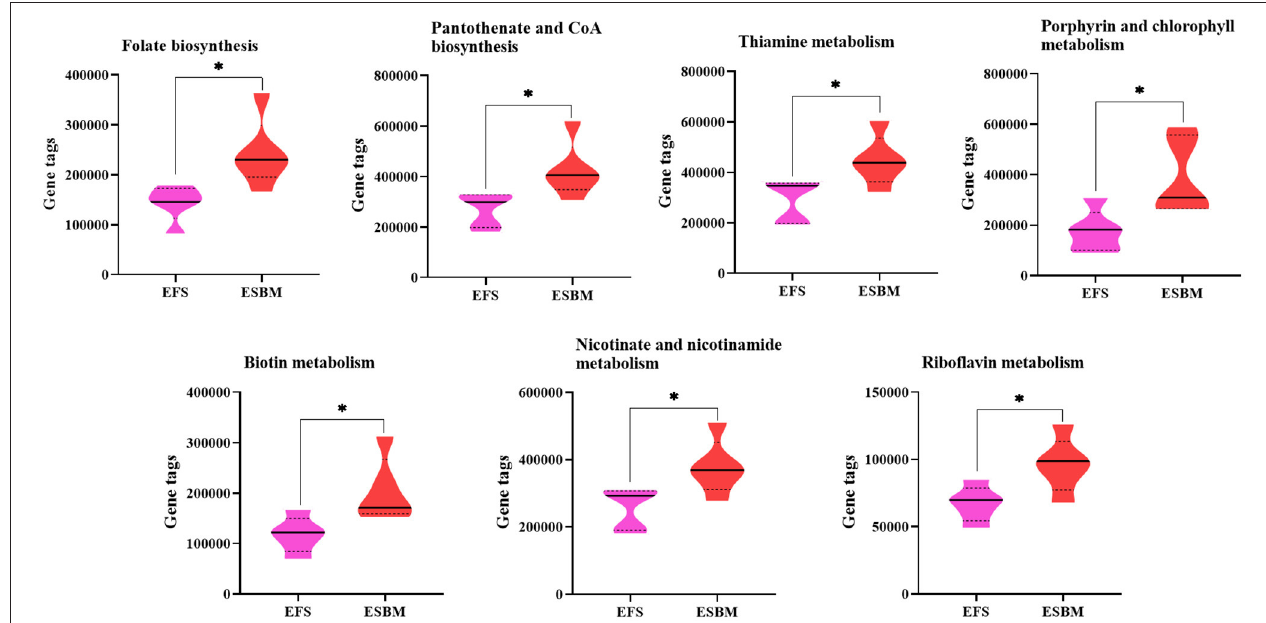
FIGURE 5 | Prediction on vitamins and coenzymes metabolism of bacterial communities using the PICRUSt program. The individual minipig was regarded as the experimental unit, n = 5 for EFS, n = 5 for ESBM. EFS, extruded full-fat soybean; ESBM, enzyme-treated soybean meal. * P < 0.05.